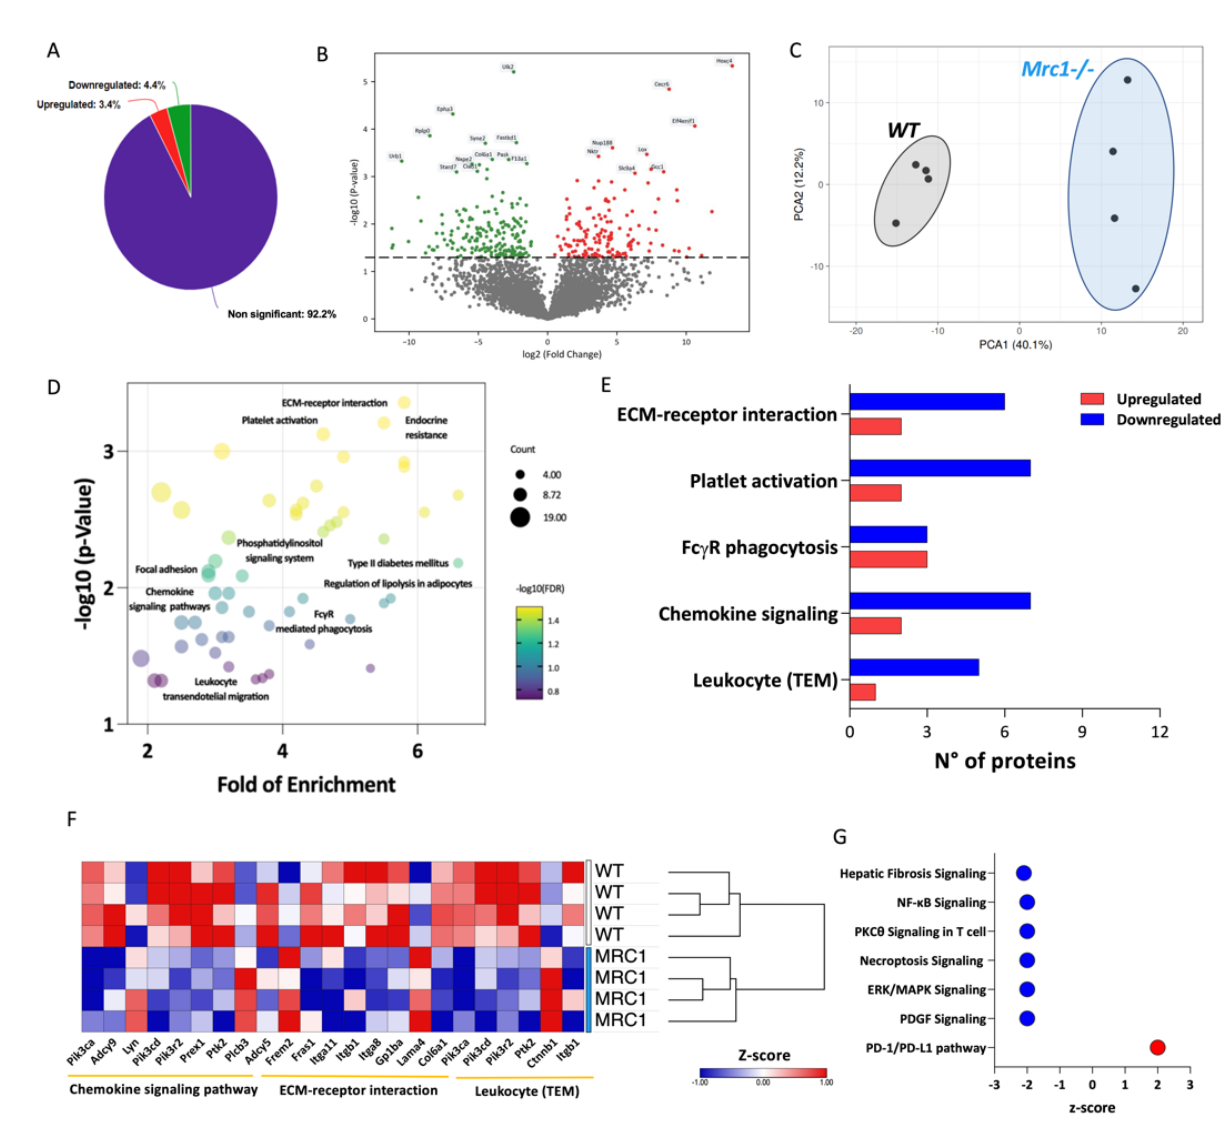
Figure 2. Plasma proteomics profiling of Mrc1 − / − and WT mice fed with an HFD for 20 weeks. ( A ) Percentage of significantly upregulated (red), significantly downregulated (green), and unchanged (purple) proteins in the plasma from Mrc1 − / − mice compared to WT. ( B ) Plasma proteome volcano plot showing log2 fold of change ( x -axis) and the − log10 p -value ( y -axis) of Mrc1 − / − mice versus WT (upregulated proteins are shown in red, p < 0.05, FC > 1; downregulated proteins are shown in green, p < 0.05, FC < − 1). ( C ) Principal component analysis (PCA) of the plasma proteome from WT (grey ellipse) and Mrc1 − / − (blue ellipse). ( D ) Dot plot showing fold of enrichment ( x -axis) and the –log10 p -value ( y -axis) of enriched pathways following KEGG database analysis. ( E ) The number of up- and downregulated proteins within the enriched pathways following KEGG database analysis. ( F ) Hierarchical clustering and heatmap showing relative protein expression values (Z-score transformed LFQ protein intensities) of significantly different proteins between WT and Mrc1 − / − mice of the indicated KEGG pathways. ( G ) Downregulated or upregulated pathways as per Ingenuity Pathway Analysis (IPA) of plasma proteome profile of Mrc1 − / − compared to WT mice. Results are expressed as mean ± SEM, n = 8–10 mice per group.